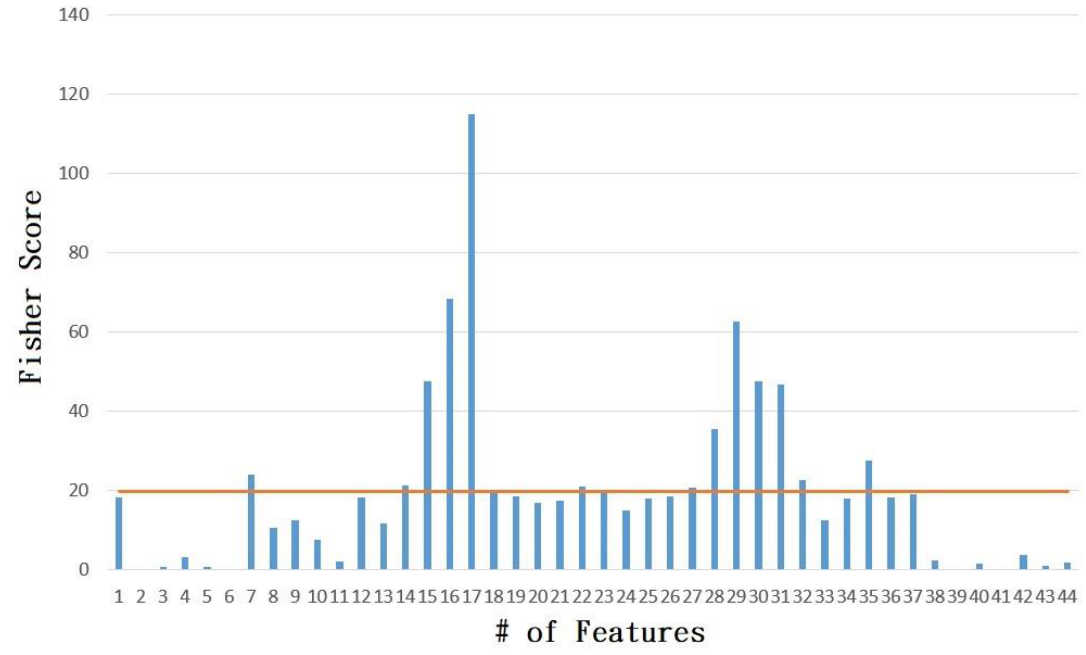
Figure 12. Selection of 14 of the 44 features based on the Fisher criterion.